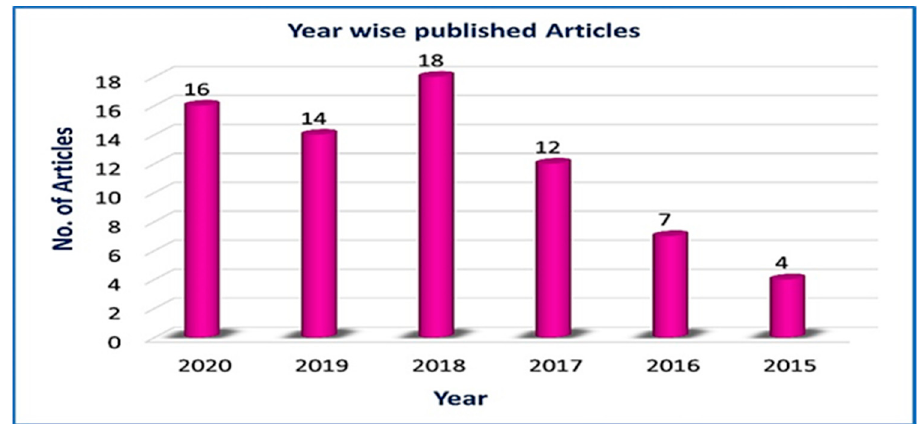
Figure 6. Selection of articles for review by year of publication.